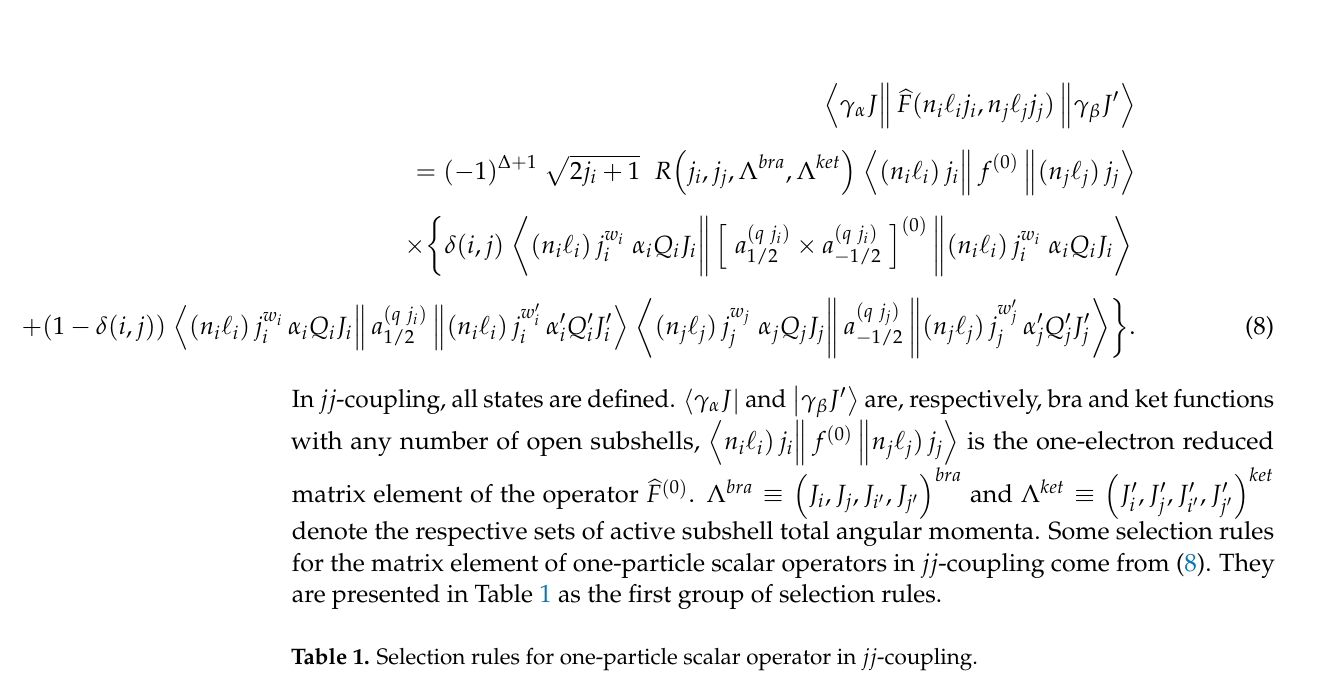
Table 1. Selection rules for one-particle scalar operator in jj -coupling. The Matrix Element